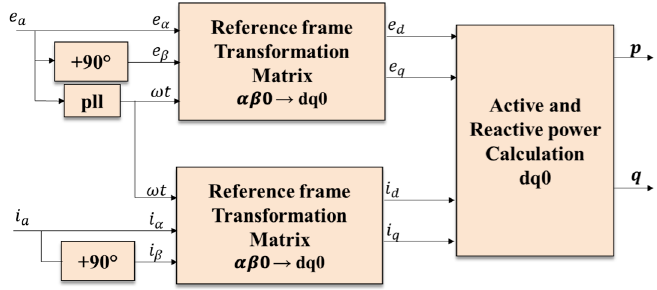
Figure 8. Power calculation by dq0 method.